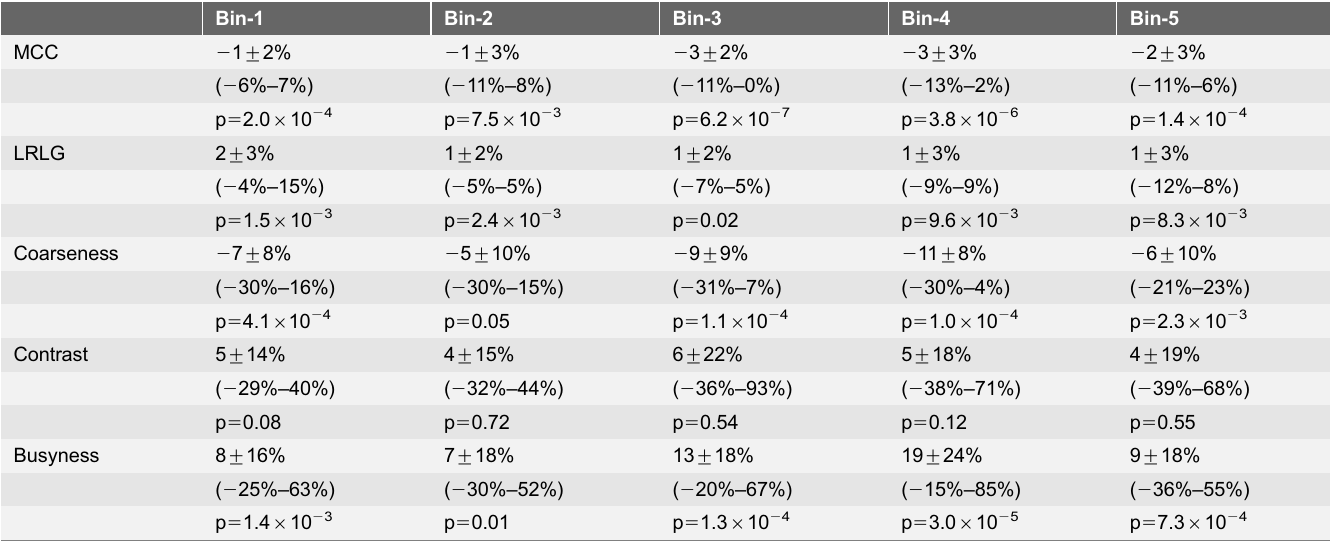
Table 1. The mean difference ( d 3D-4D ) between 3D and 4D PET images in texture